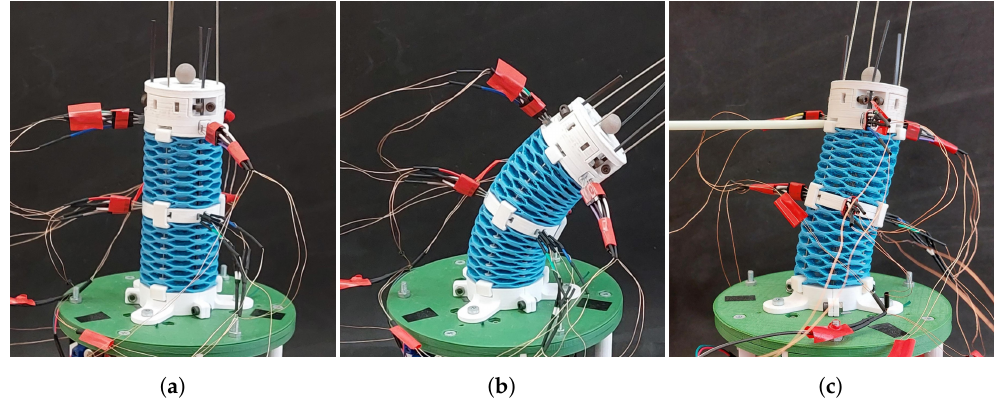
Figure 14. Robot prototype in selected postures: ( a ) rest (homing) position, ( b ) bent posture, ( c ) radial displacement resulting from an external force applied by the white rod to the left.